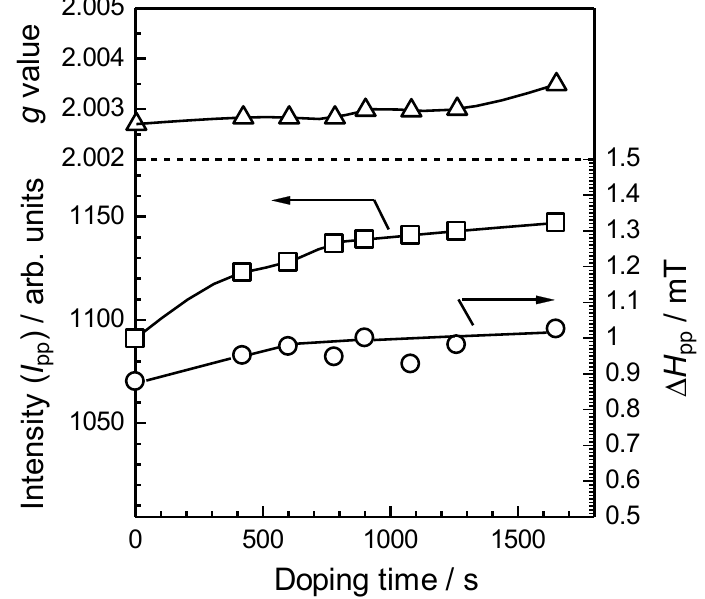
), and linewidth (Δ H ) are pp pp